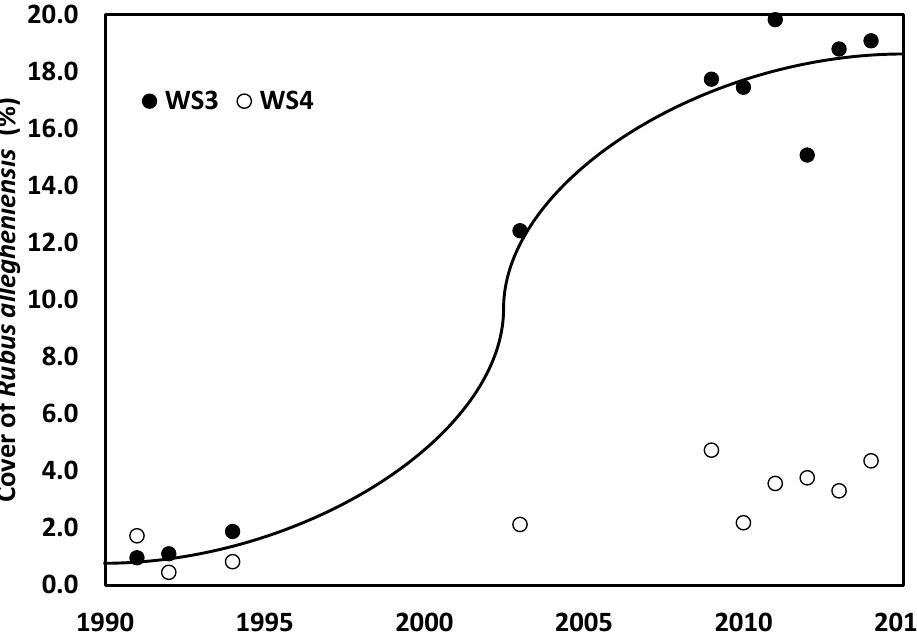
Figure 5. Changes in cover of Rubus allegheniensis in response to a quarter century of N additions at Fernow Experimental Forest, West Virginia. Data taken from Gilliam et al. [11].